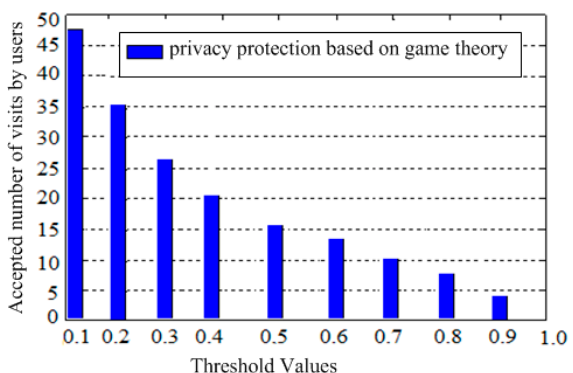
Figure 5. Comparison of the privacy protection between the traditional and game-based protection models.